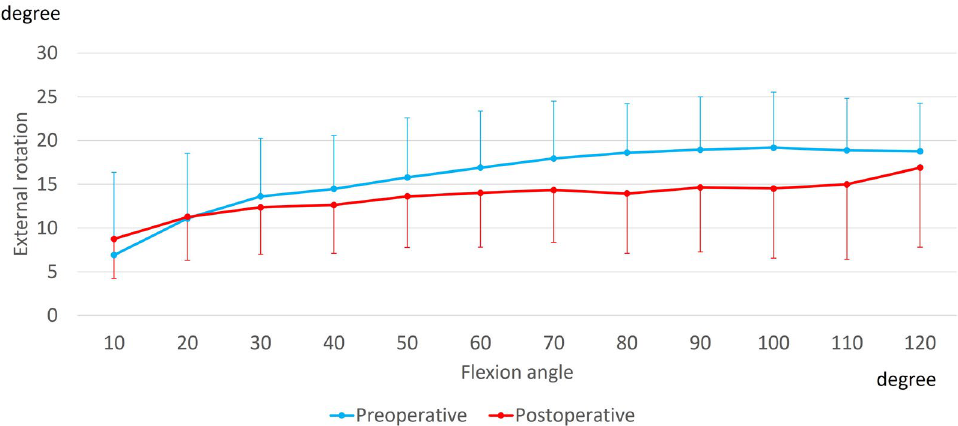
Figure 1. Rotation angle during squatting. The femur displayed external rotation with